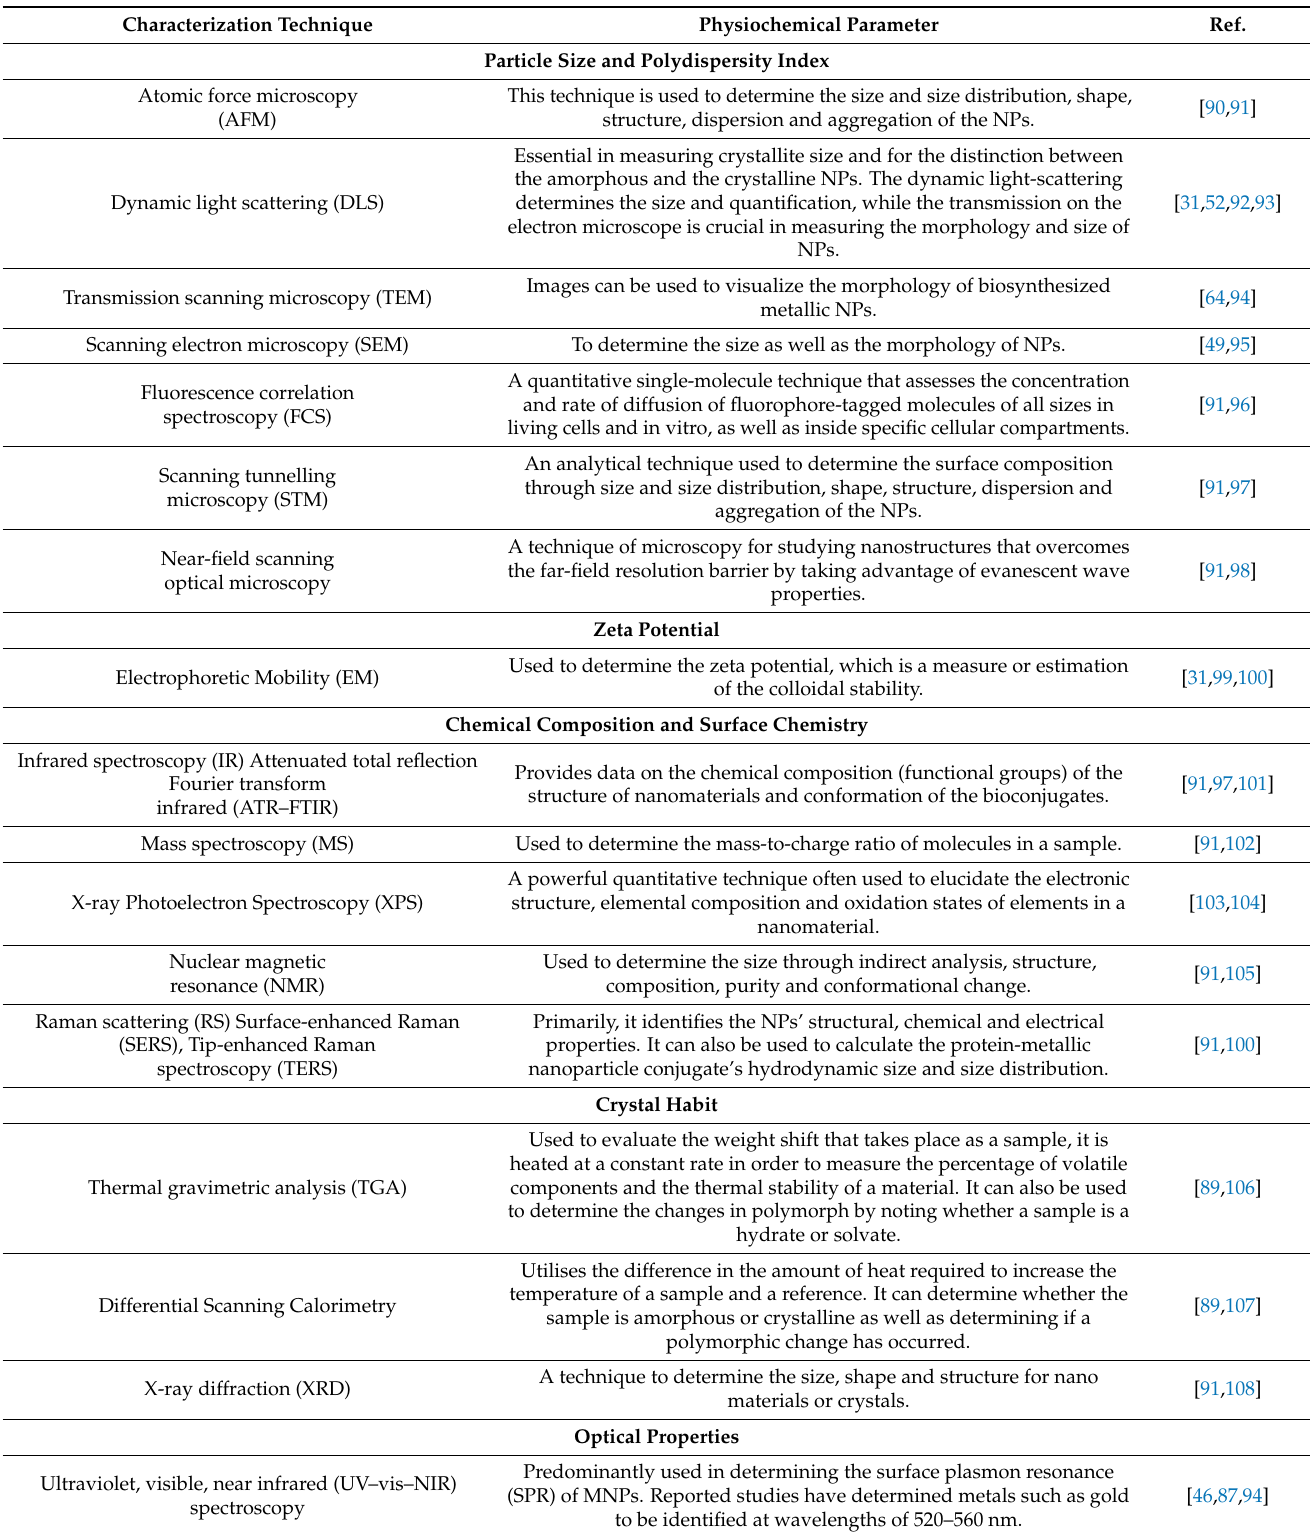
Table 2. A summary of the different characterisation techniques utilised for theranostics